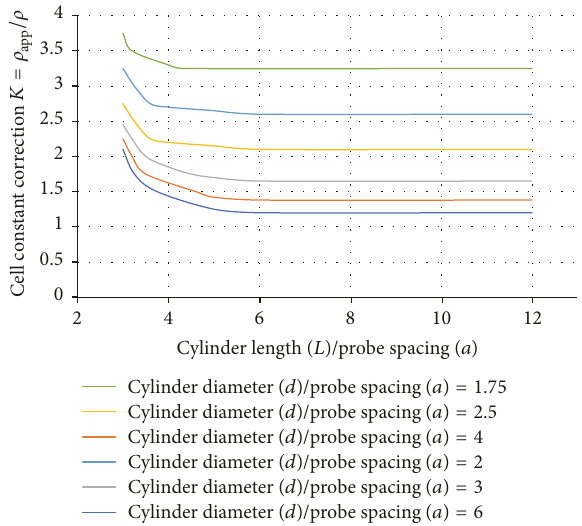
Figure 9: Cell constant correction to determine the concrete resistivity